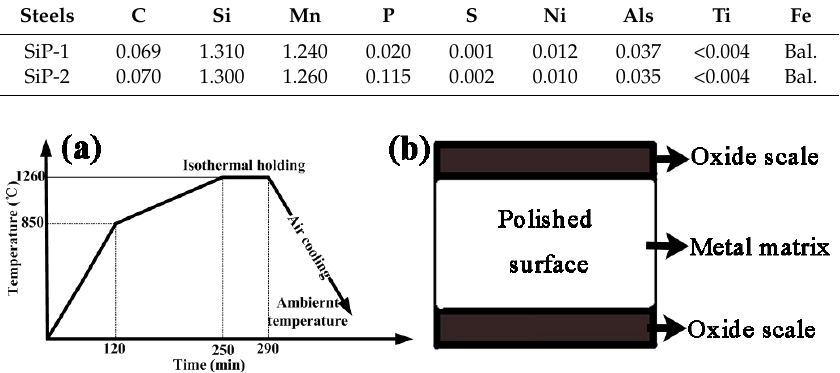
Figure 1. ( a ) The industrial heating procedure; ( b ) The schematic diagram of a sample for in situ observation.